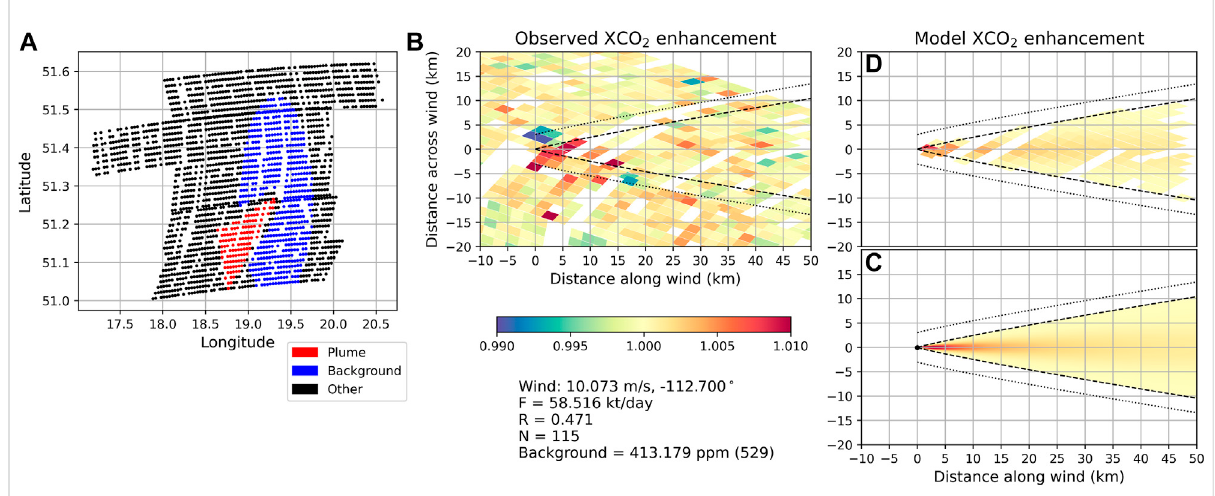
FIGURE 7 Same as Figure 4 for OCO-3 Be ł chat ό w SAM on 2021-10-08. The observed XCO 2 plume appears weak due to the high wind speed (10.07 m/s) dissipating the